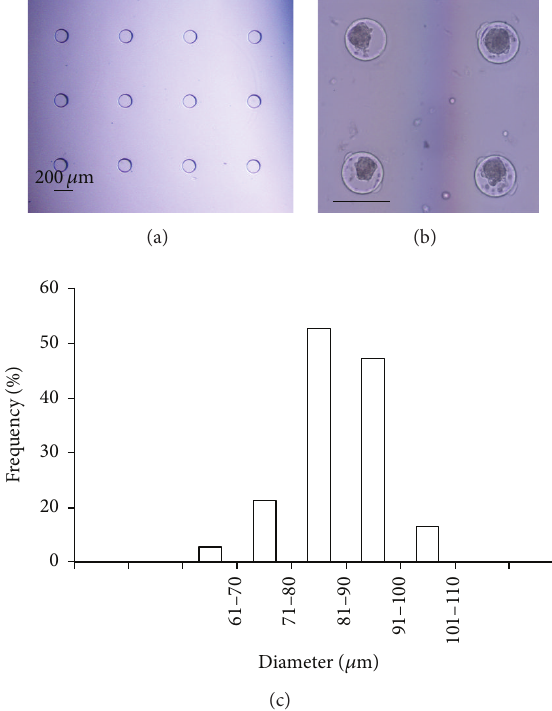
Figure 1: Microwells for culturing AdMSCs derived aggregates. (a) Phase contrast image of microwell. (b) Phase contrast image of AdMSCs aggregates formed in microwell. Black bar indicates 200 𝜇 m. (c) Frequency distribution of diameter of aggregates formed in